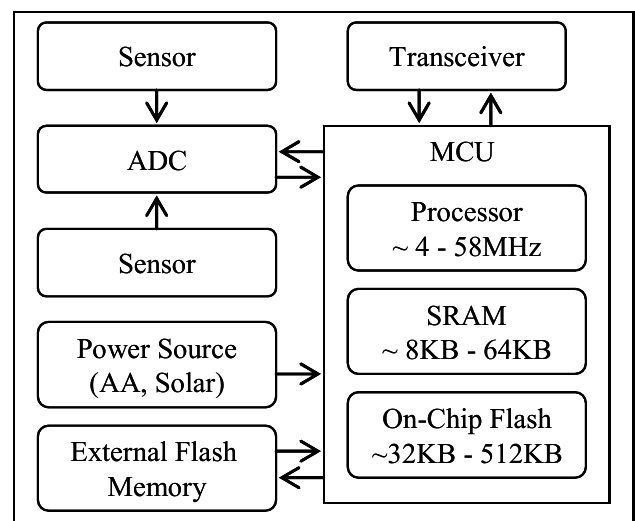
Figure 1. Sensor node